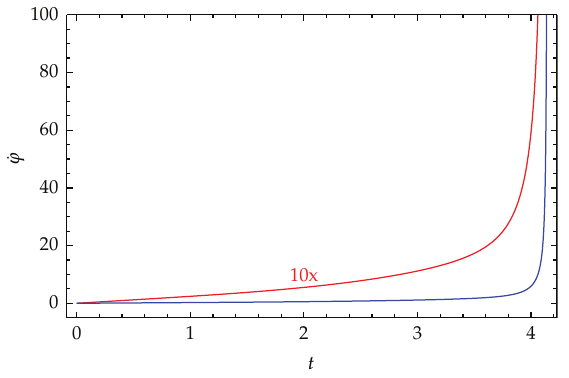
Figure 5: ˙ ϕ/H 0 and 10 ˙ ϕ/H 0 versus t/t 0 .